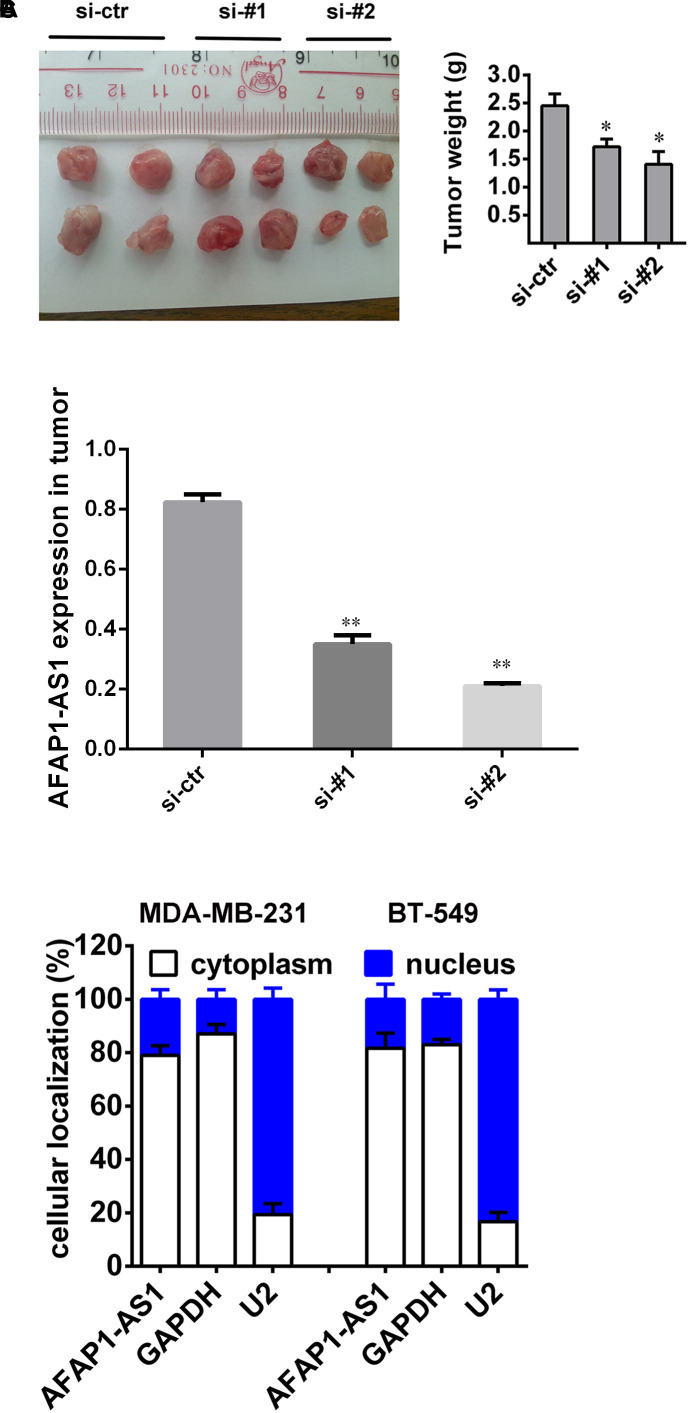
Silencing AFAP1-AS1 inhibited tumorigenesis in vivo. (A) A representative picture of the morphology of tumor xenografts after 28 days of treatment (left). The tumor weights of the xenografts are summarized in the right panel. All results are expressed as the mean ± SD of three independent experiments (∗P < 0.05). (B) siRNA knockdown efficiency of AFAP1-AS1 expression in tumors by qRT-PCR (∗∗P < 0.01). (C) AFAP1-AS1 cellular localization indicating AFAP1-AS1 mainly localized in the cytoplasm of cells.